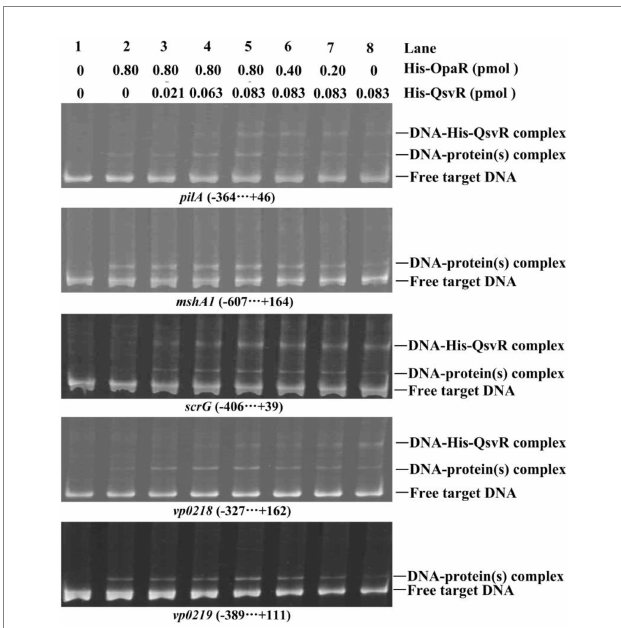
FIGURE 8 Competitive DNA-binding assays. The experiments were carried out as described in Figure